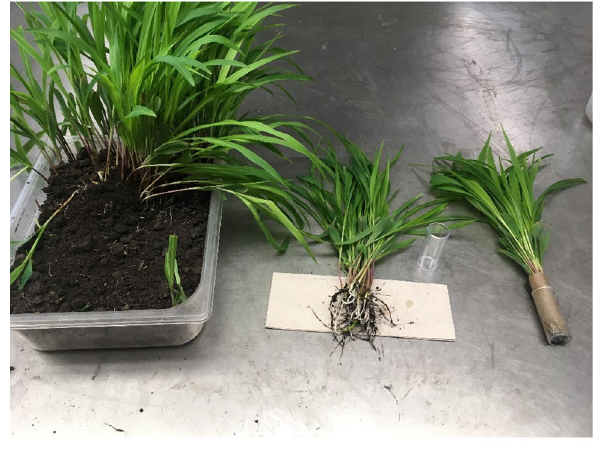
Figure 5. Corn bundles provided in adult emergence container.